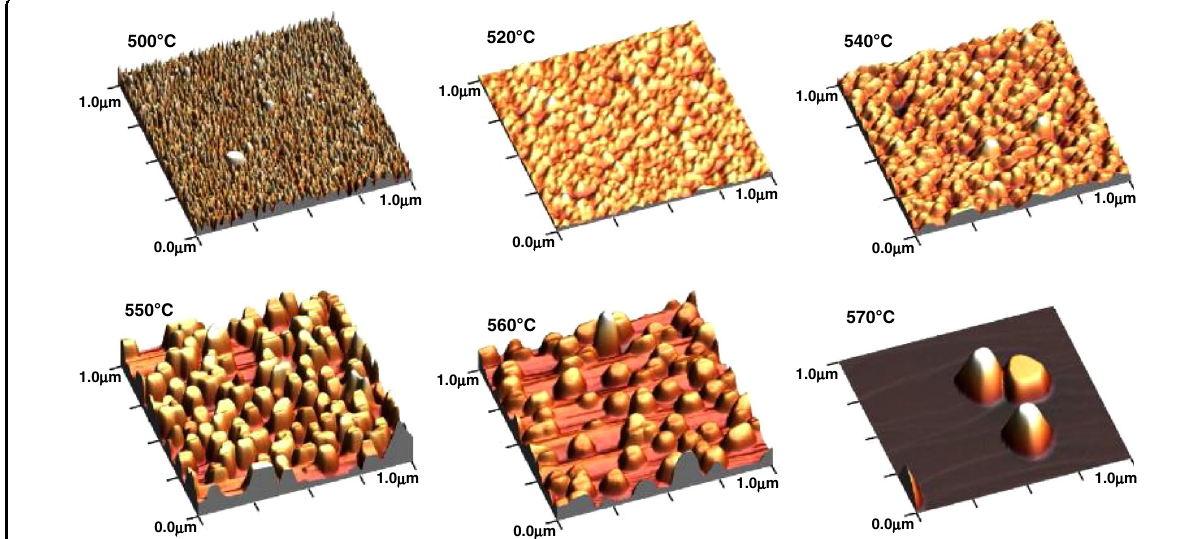
Fig. 5 InN QDs in 3D AFM (1 μ m)2 scans with indicated growth temperatures. Reprinted from Meissner et al., “ Indium nitride quantum dot growth modes in metalorganic vapor phase epitaxy ” . J. Cryst. Growth , 310/23, 4959-4962, Copyright (2008), with permission from Elsevier